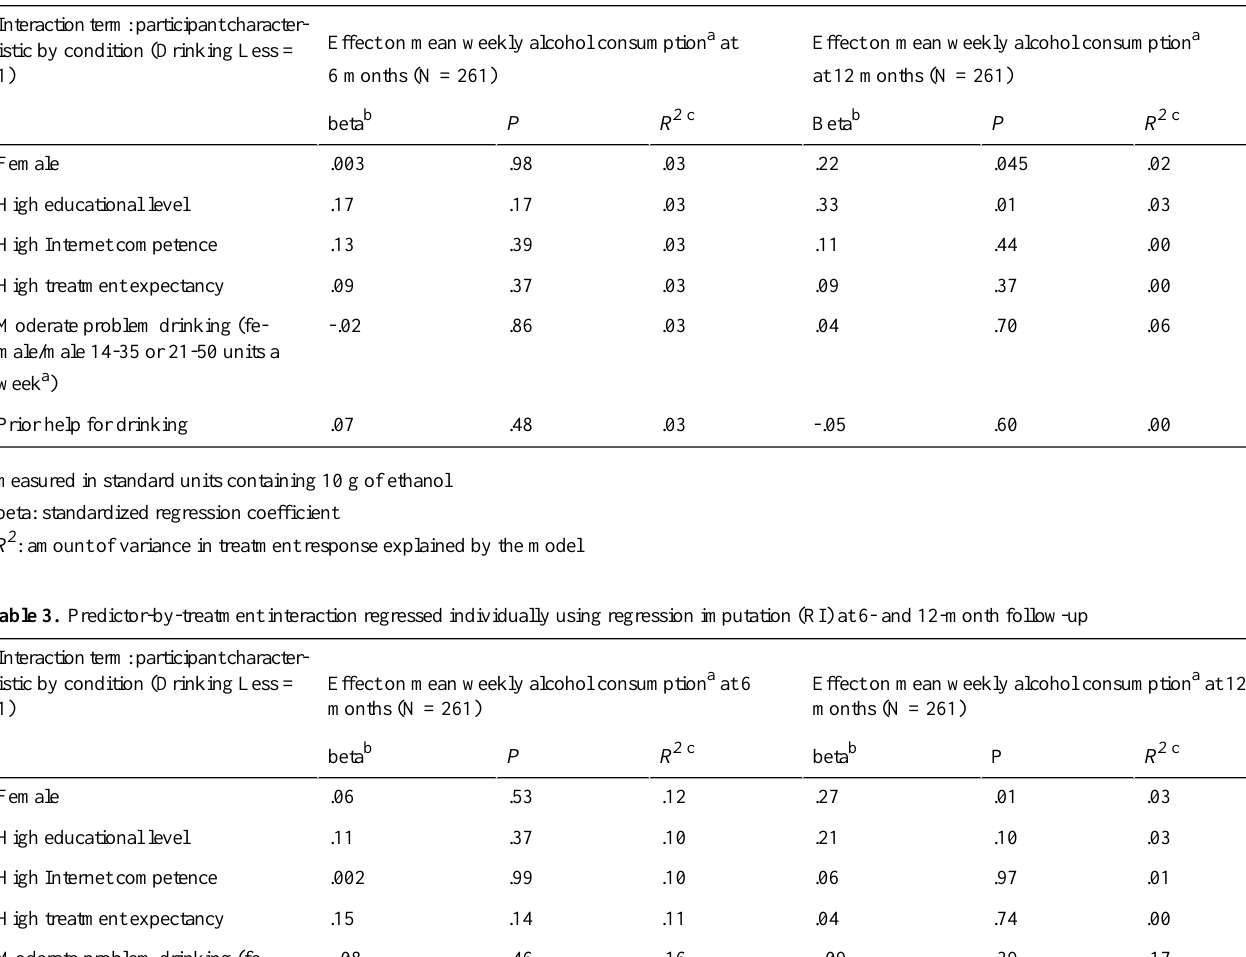
Table 2. Predictor-by-treatment interaction regressed individually using last-observation-carried-forward (LOCF) imputation at 6- and 12-month